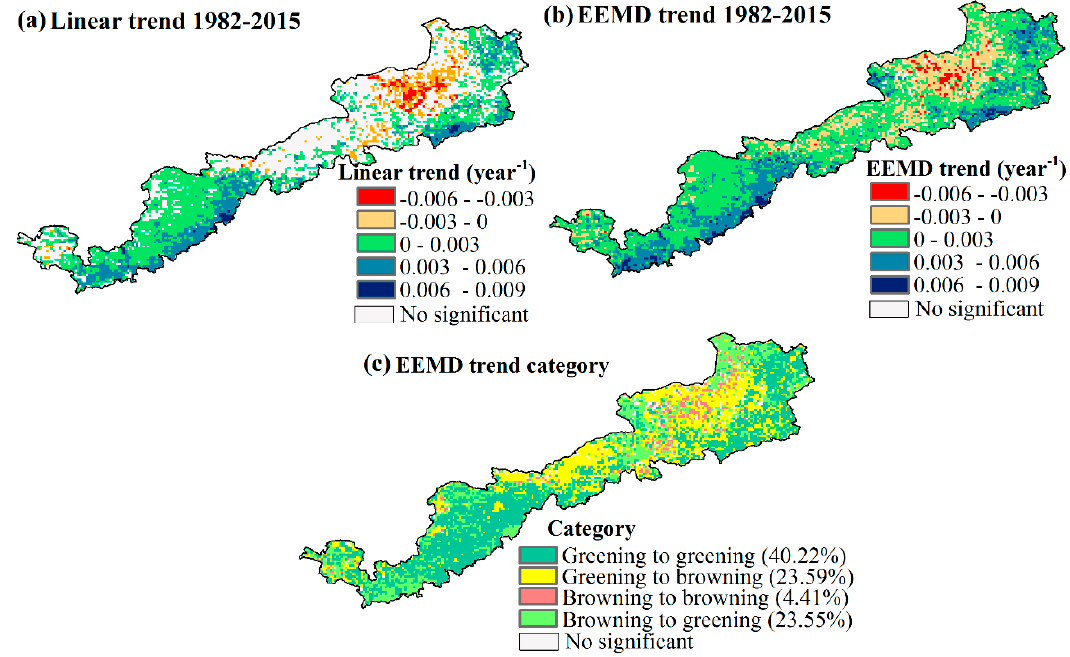
Figure 8. Spatial distribution of linear trends ( a ) and EEMD trends ( b ) in the NDVI during 1982–2015, and the EEMD trend classification in the APENC ( c ). Only pixels with P < 0.05 are presented.